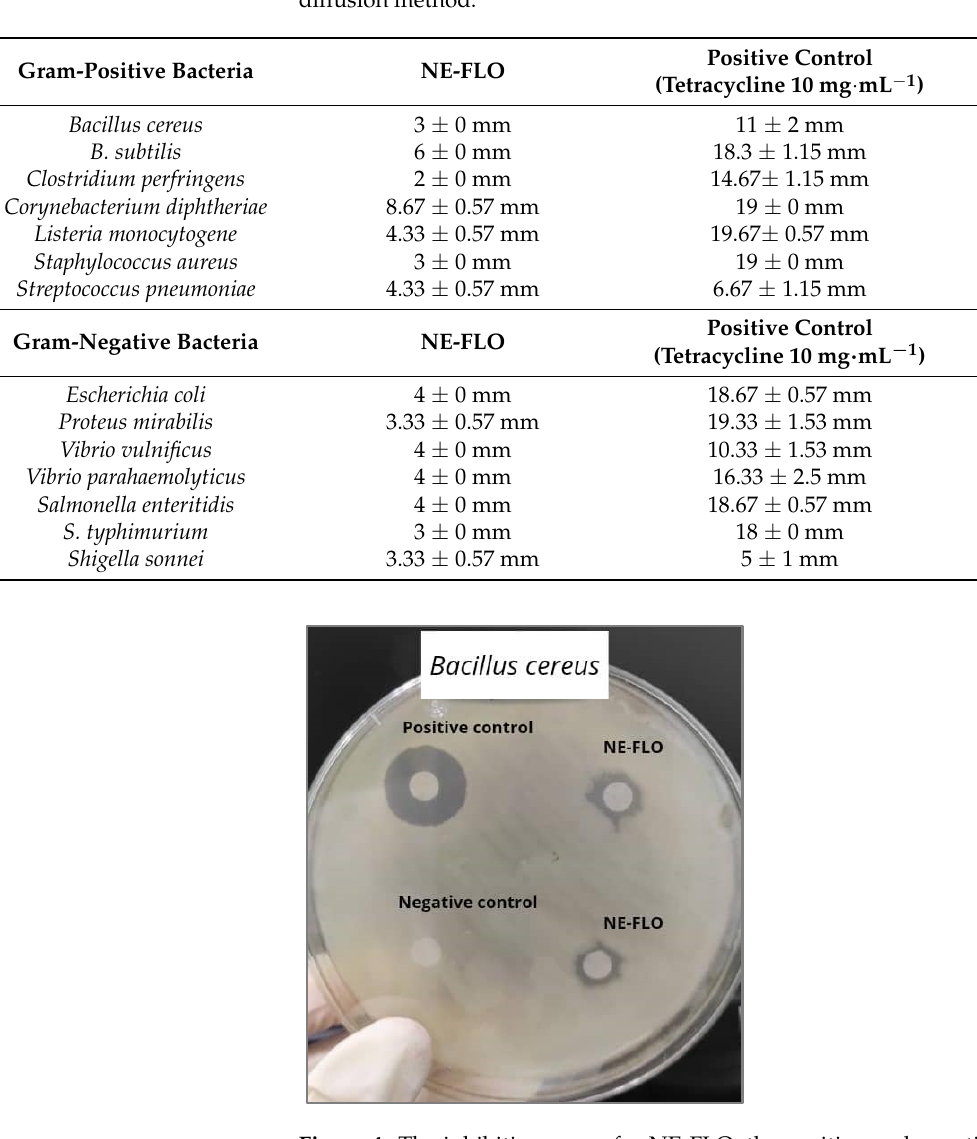
Figure 4. The inhibition zones for NE-FLO, the positive and negative control against B. cereus as, an example of the antibacterial activity of the NE-FLO.